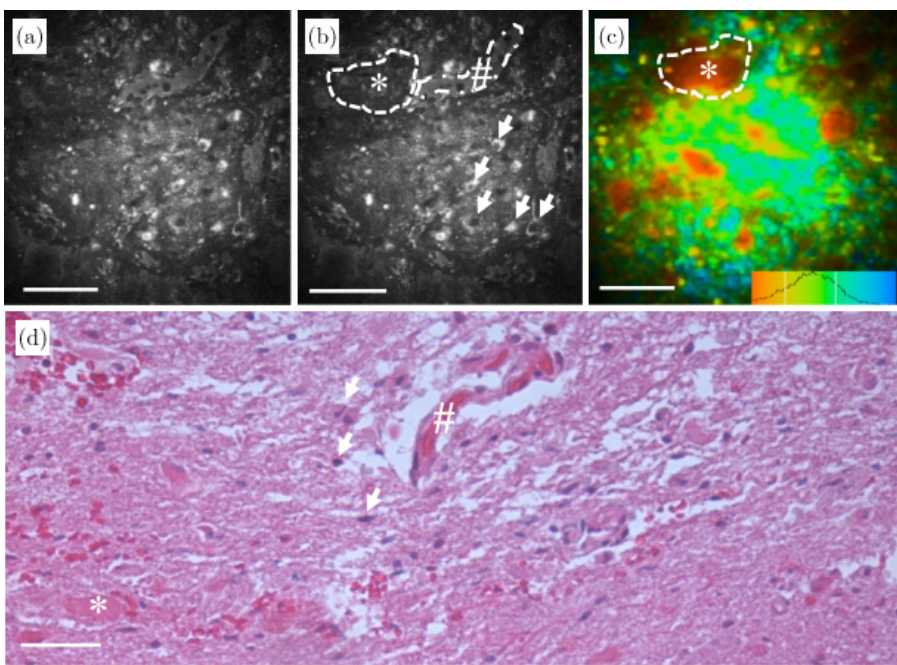
Notes : Necrosis is marked with \*". Microvascular proliferation is marked with \#". Fig. 6. Multiphoton intensity and °uorescence lifetime imaging of human glioma tissue ex vivo . (a) and (b) °uorescence intensity images, (c) °uorescent lifetime images, (d) conventional histology of the tumor (HE (hematoxylin-eosin) staining of a region resembling the area examined by MPT), examples of cell pleomorphism are marked with white arrows. The white bars correspond to a distance of 50 (cid:1) m. 33 (Permission has been granted by \Springer" through Copyright Clearance Center's RightsLink r